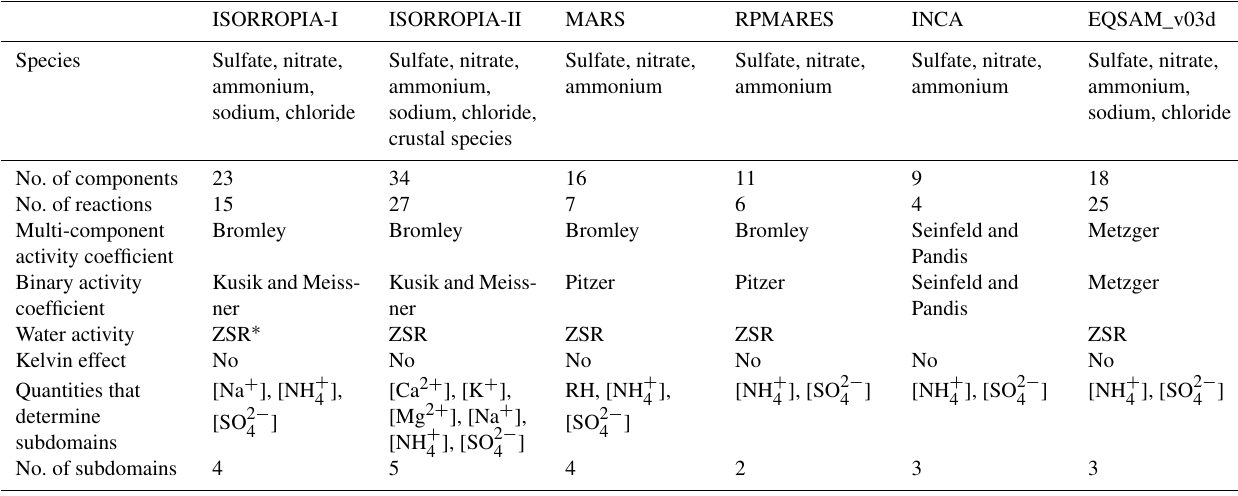
Table 2. Characteristics of thermodynamic equilibrium